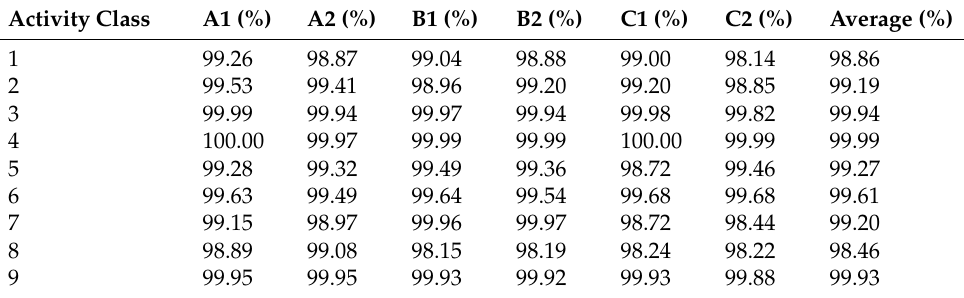
Table 5. Average cross-validation activity classes